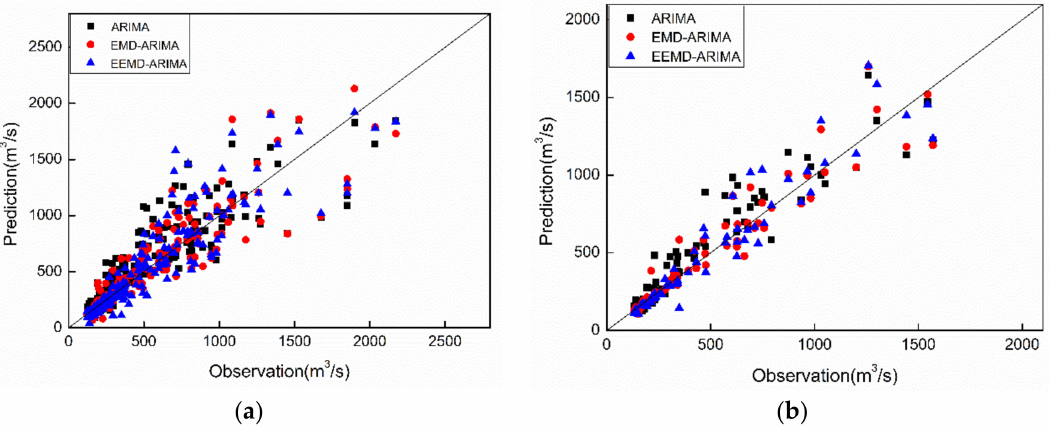
Figure 5. Comparison of deviation between streamflow prediction and historical data by proposed hybrid methods from the year 2013 to 2017 with a time step of ( a ) ten days; ( b ) one